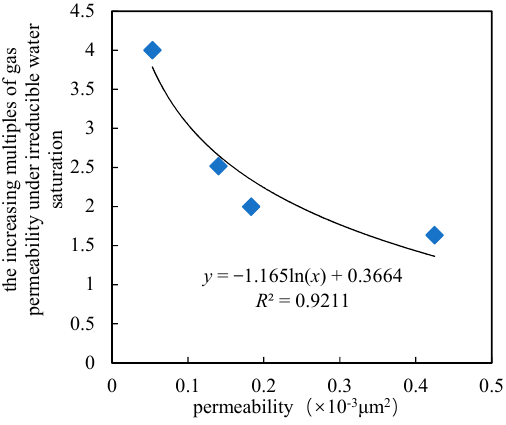
Figure 20. The increasing multiples of the gas permeability versus the irreducible water saturation under high temperature and pressure conditions.